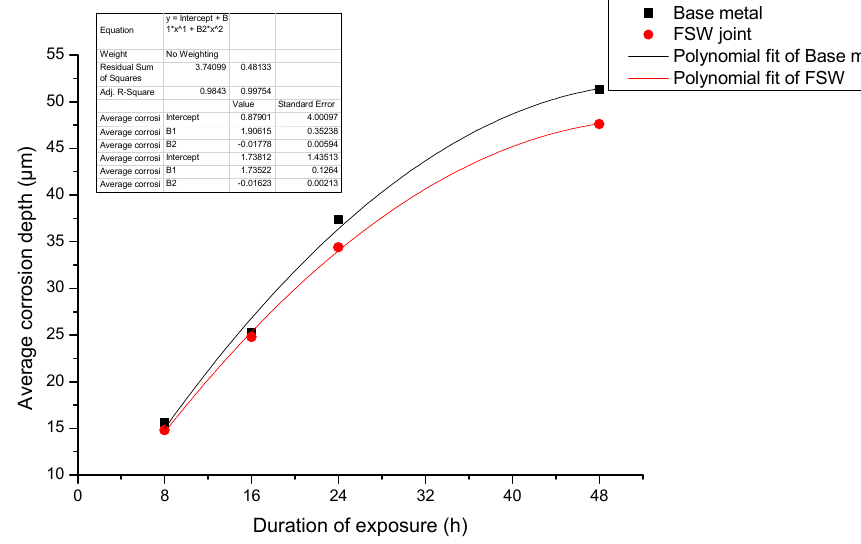
Figure 15. Variation of average corrosion depth ( µ m) with duration of exposure (h) to the environment (EXCO solution) at an applied stress ( σ ) of 79 MPa.